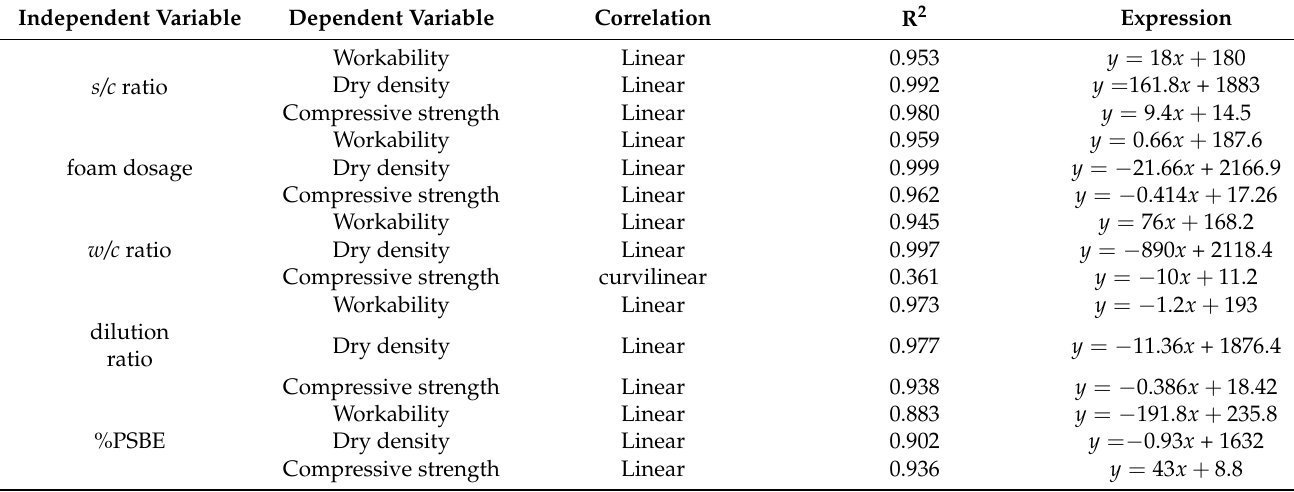
Table 5. Regression analysis of factors affecting density and compressive strength of foamed